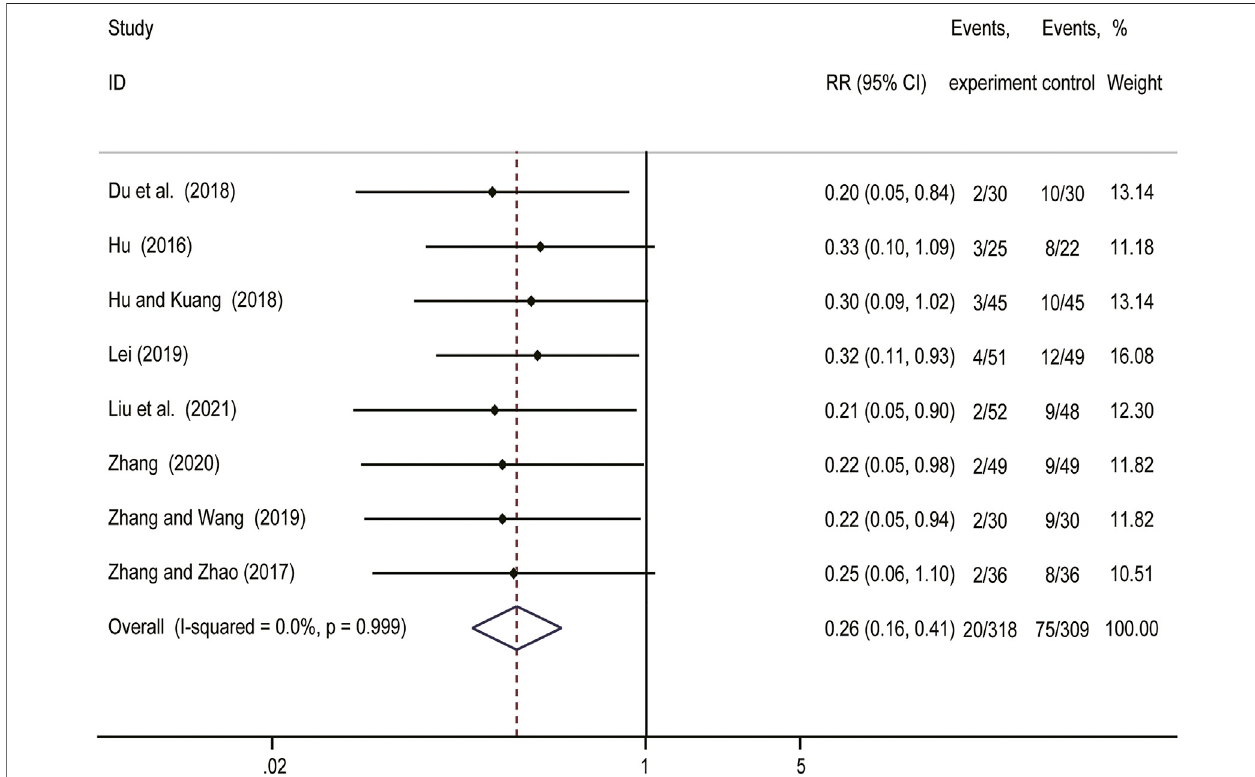
FIGURE 3 | Forest plot showing comparision of recurrence rate comparing Salvia -containing CHM combined with GnRH-a to GnRH-a alone treatment.